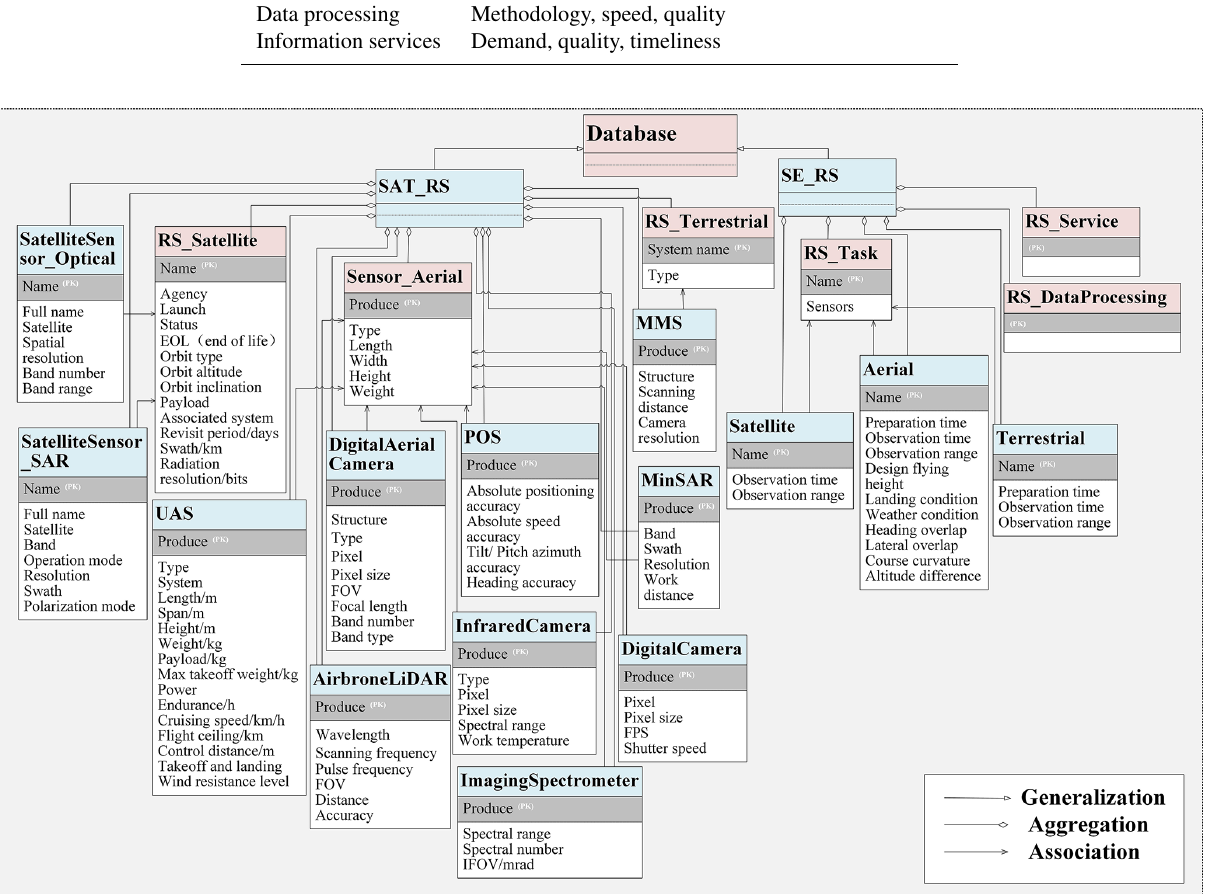
Figure 3. Unified Modeling Language (UML) of database. FPS: frames per second. IFOV: instantaneous field of view. POS: position and orientation